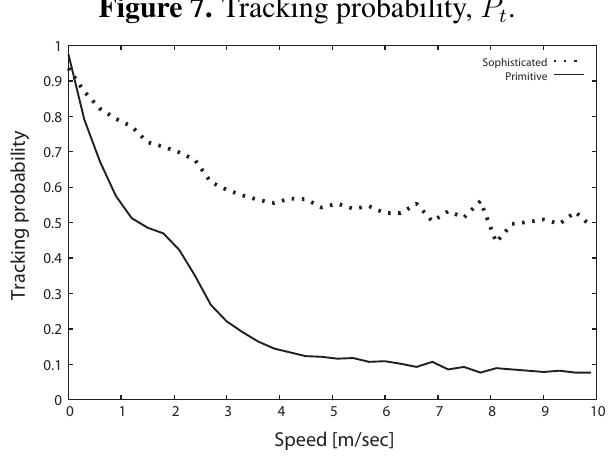
Figure 7. Tracking probability, P